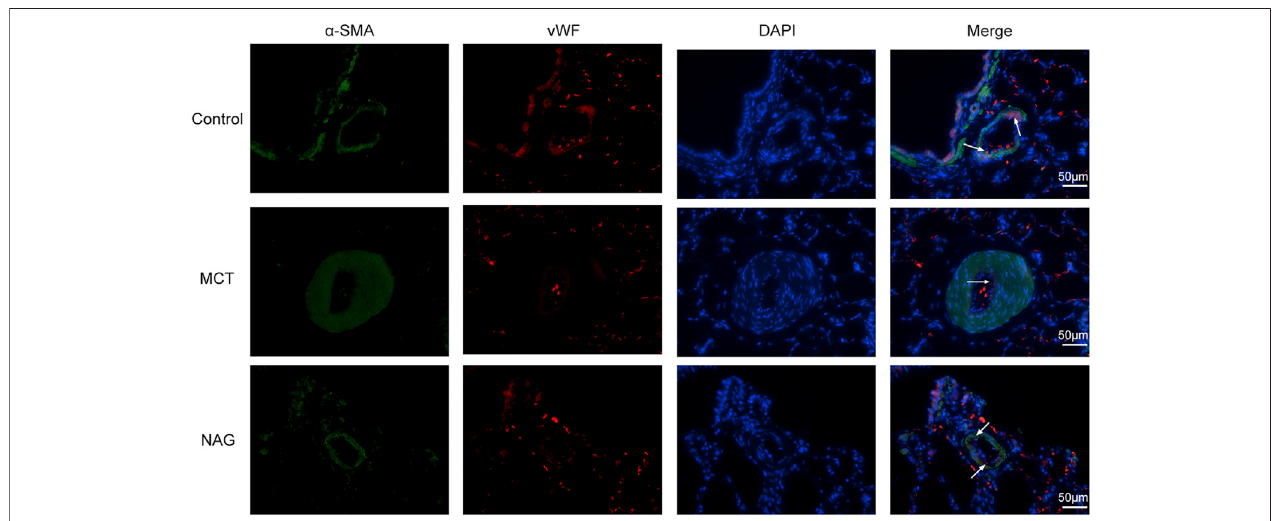
FIGURE 5 | Effects of naringin on EndMT of PAH in rats was demonstrated by immuno fl uorescence staining. Red fl uorescence represents vWF, green fl uorescence represents α -SMA and blue fl uorescence indicates DAPI nuclei staining. The white arrows in the images indicate vWF-positive cells. Magni fi cation × 400, scale bars (cid:1) 50 μ